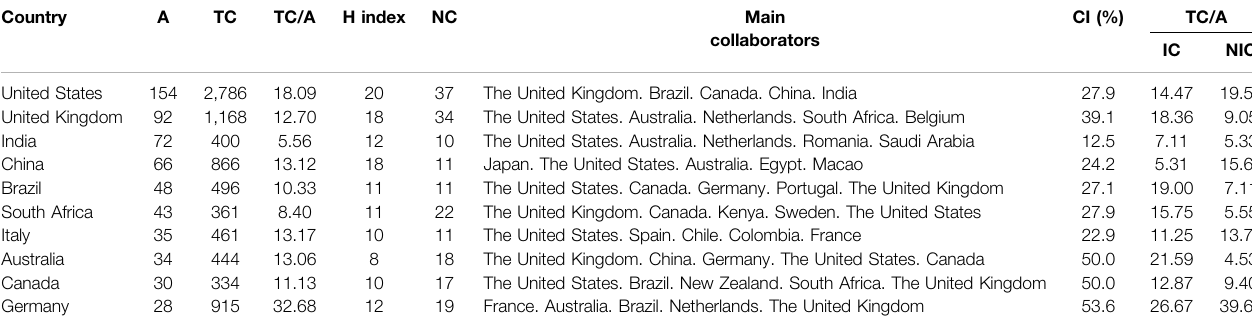
TABLE 5 | Top 10 most productive countries in sustainable crafts and their cooperative networks. Source: Authors ’ own. Country